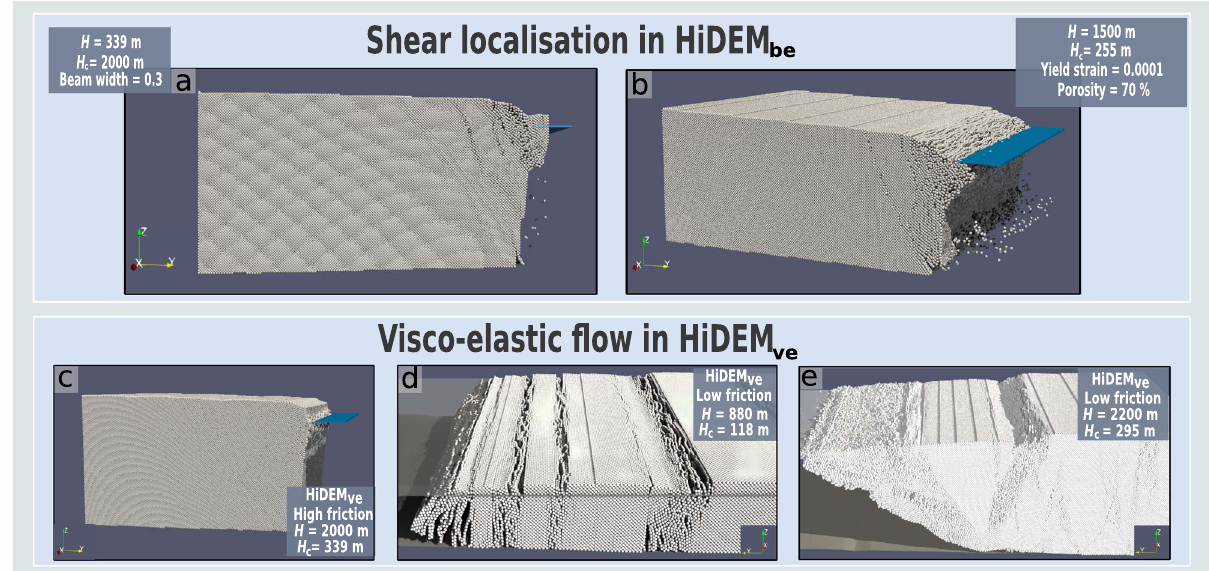
Fig. 3 Modes of structural failure dominated by shear-band formation. Shear localization is observed in HiDEM be (the brittle-elastic version of the Helsinki Discrete Element Model) simulations if, given ice-cliff height ( H c ), inter-particle beam widths are suf fi ciently narrow ( a ) or the ice is suf fi ciently weak and damaged ( b ). Damage is represented by porosity (the percentage of pre-broken bonds). c Surface slumping and waterline bulging resulting from visco-elastic deformation simulated in the viscous mode of HiDEM ve . d Vertical crevasses and calving via outward buoyant block rotation at a relatively thin glacier with substantial sliding ( f = 10 − 5 ), as simulated using the intermediate elastic-brittle and viscous mode of HiDEM ve . e Crevassing, shear bands, slumping and mélange growth were observed as thickness and friction increased ( f = 10 − 4 ) using the same intermediate mode of HiDEM ve as in d ). Details on f are included in Supplementary Note 7. H = calving face thickness. Blue and white transparent planes represent the